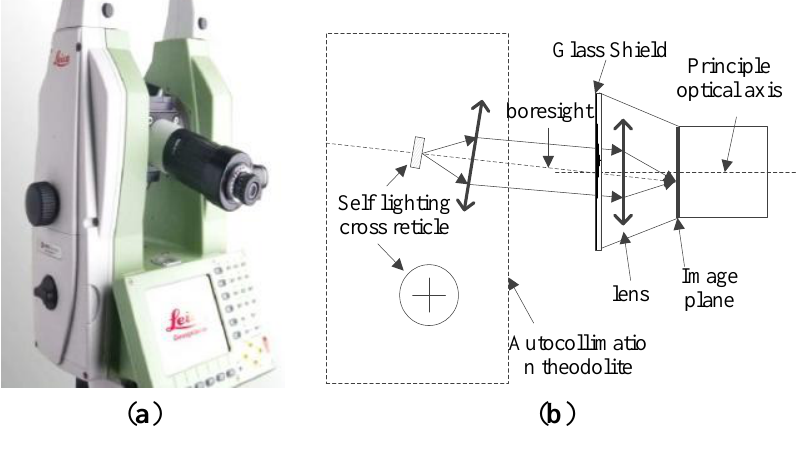
Figure 9. ( a ) External view; ( b ) Internal structure of the autocollimator Theodolite 6100A.